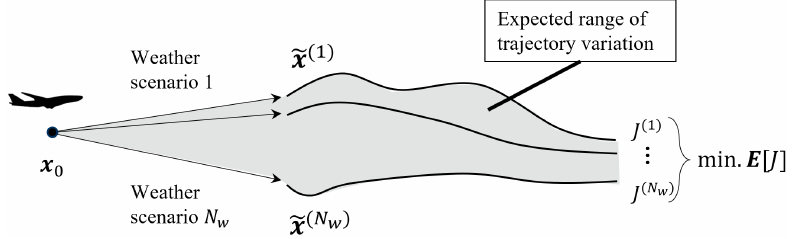
Figure 4. Overview of the process of the proposed robust planning